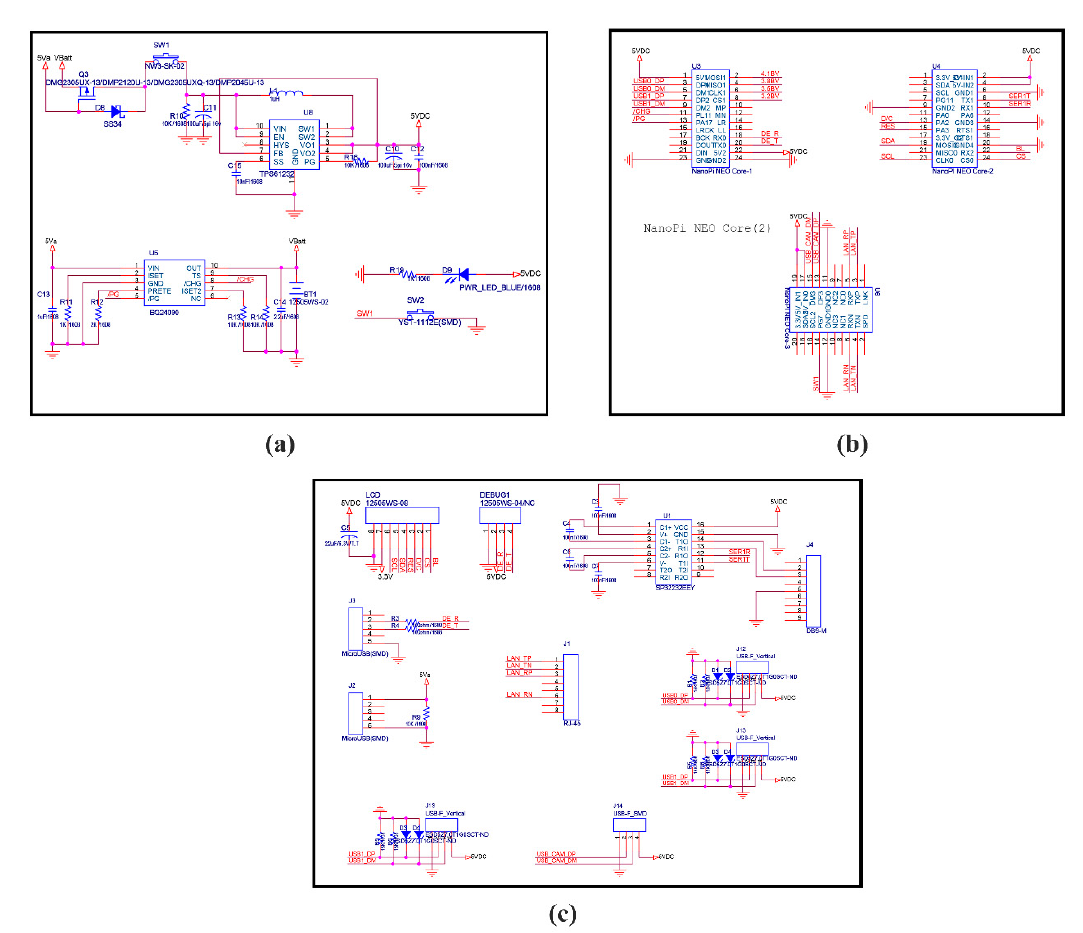
Figure A4. Schematic diagram of the NEO TINY system client depicting: ( a ) Main Board, ( b ) Power Supply, ( c ) Communication Ports.